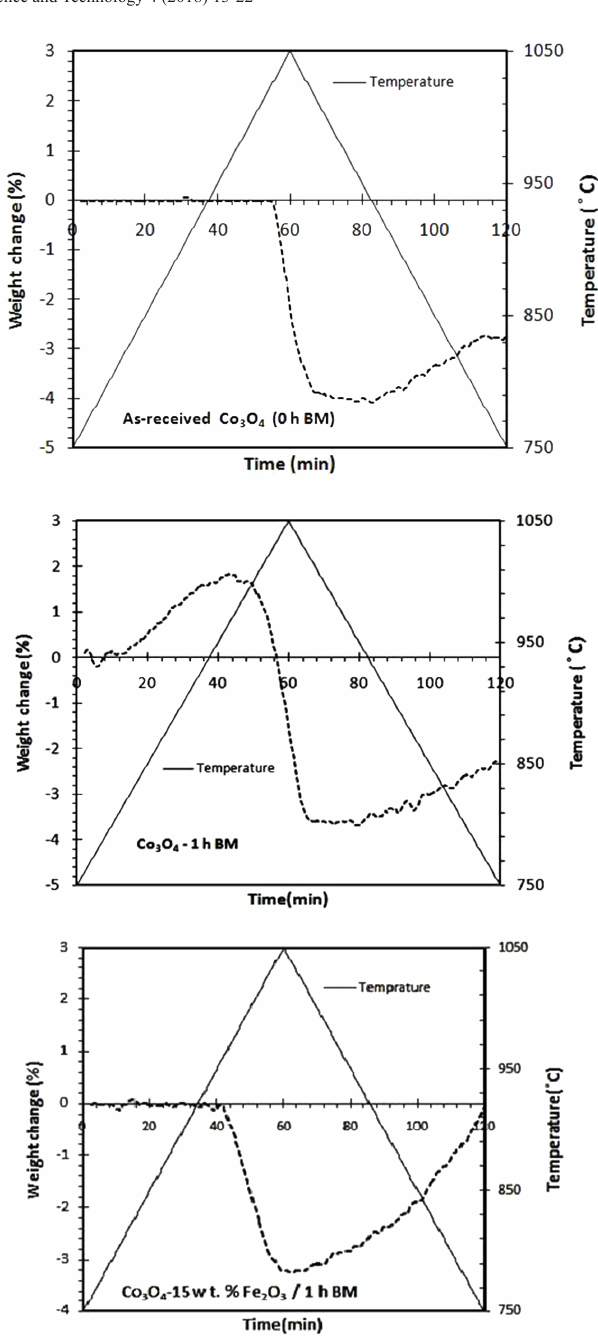
Fig. 1. TG curve of as-received Co 3 O 4 , Co 3 O 4 /1h BM and Co 3 O 4 - 15wt% Fe 2 O 3 / 1 h BM samples.